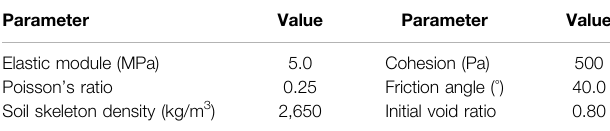
TABLE 2 | Table of parameters in SPH simulation of a soil slope vibration table test. Parameter